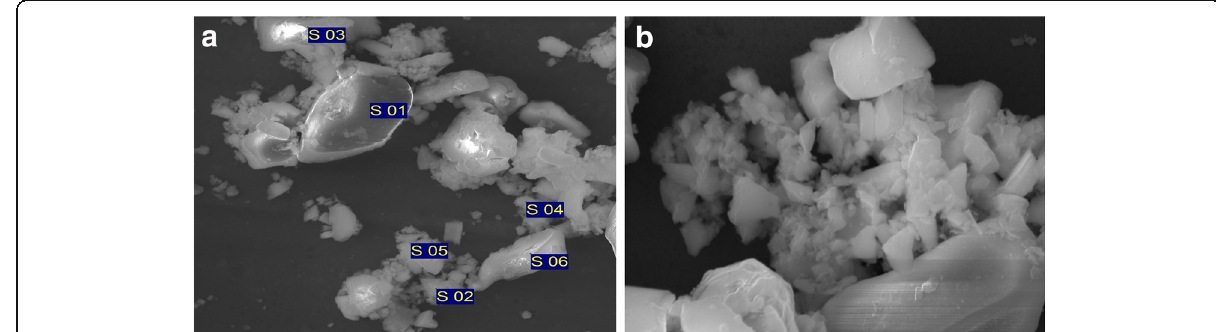
Fig. 1 SEM-images of fine ZnS:Cu, obtained by SHS method. a General view. b Mixture particles of different